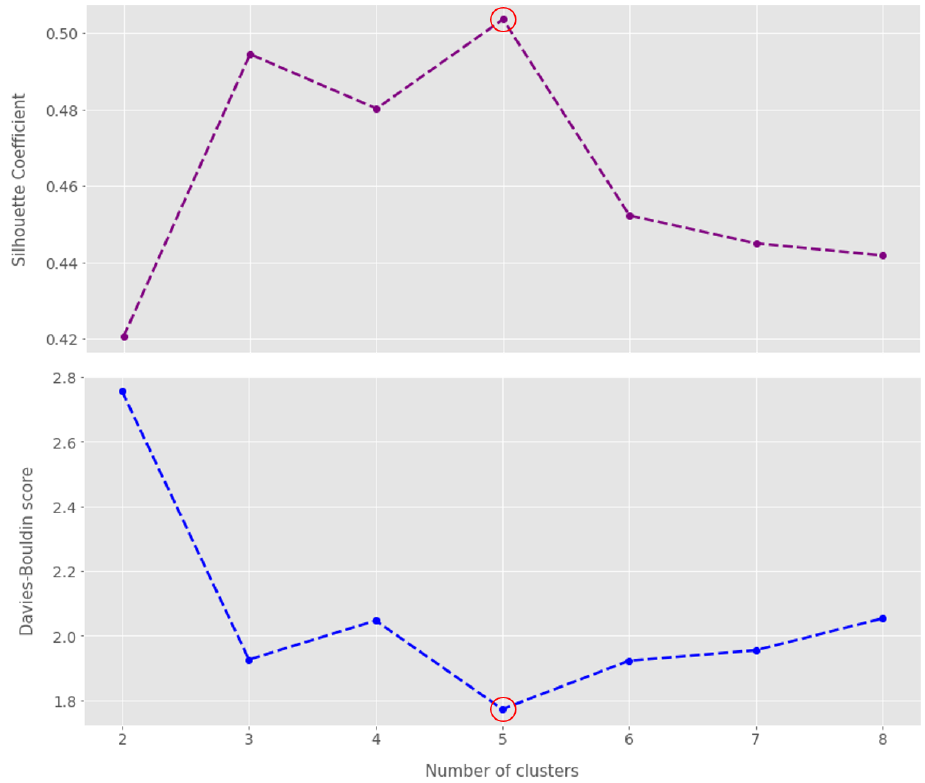
Figure 5. The top panel shows the average Silhouette coefficient and the bottom panel shows the DB score for versus number of clusters. The optimal number of clusters is identified by the red circle at the